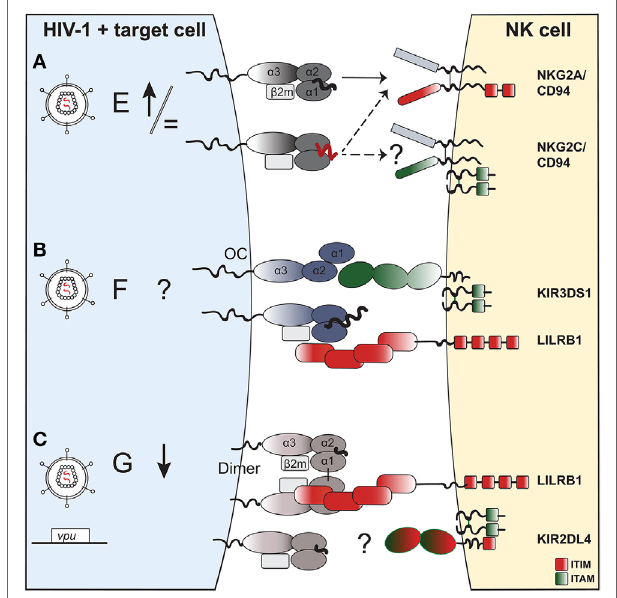
FigURe 2 | The potential impact of HIV-1 infection on expression of non-classical human leukocyte antigen class I (HLA-I) molecules on a target cell and effect on natural killer (NK)-cell receptor binding. (A) HLA-E. HIV-1 infection of target cells leaves HLA-E surface levels either unchanged or slightly upregulated. HLA-E can present self-peptides (in black) that bind to the NKG2A:CD94 receptor complex, and inhibit NK-cell function. In the context of HIV-1 infection, HLA-E can present viral or “stress”-self-peptides (in red) that abrogate (or reinforce) binding to NKG2A:CD94 and modulate NK-cell activity. The potential role of viral or “stress” peptides presented on HLA-E that could trigger the activating NKG2C:CD94 receptor complex on NK cells is currently unknown. NKG2C associates to DAP12, an adaptor molecule containing two ITAMs. (B) HLA-F. The exact impact of HIV-1 infection on HLA-F surface expression in different cell types needs yet to be established. In general, HLA-F is expressed on activated or stressed cells, potentially in distinct functionally relevant conformations: (i) an open conformer that binds to the activating NK-cell receptor KIR3DS1 or (ii) a β 2 m-bound complex presenting peptides of unusually long length for HLA-I, which allows binding of the inhibitory receptor LILRB1. (C) HLA-G: